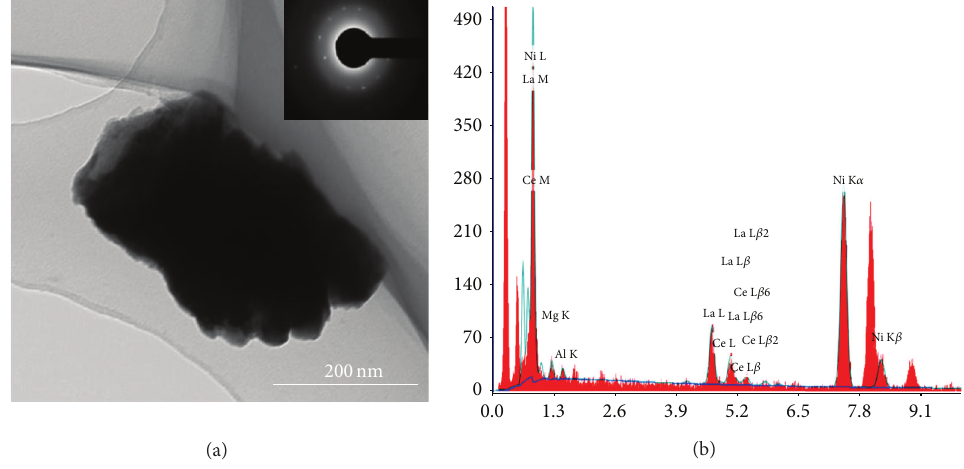
Figure 2: TEM and EDS La 0.96 Ce 0.04 Mg 0.15 Al 0.05 Ni 2.8 alloy.